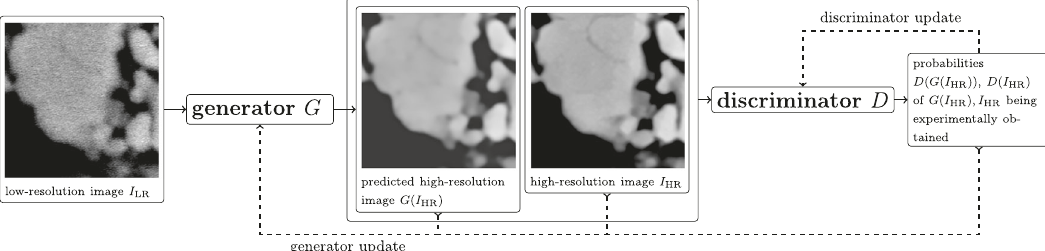
Fig. 2 Scheme for training the SRGAN. Training procedure according to the optimization problem given in Formula (3) when matching pairs of experimentally measured low-resolution images I LR with corresponding high-resolution versions I HR are